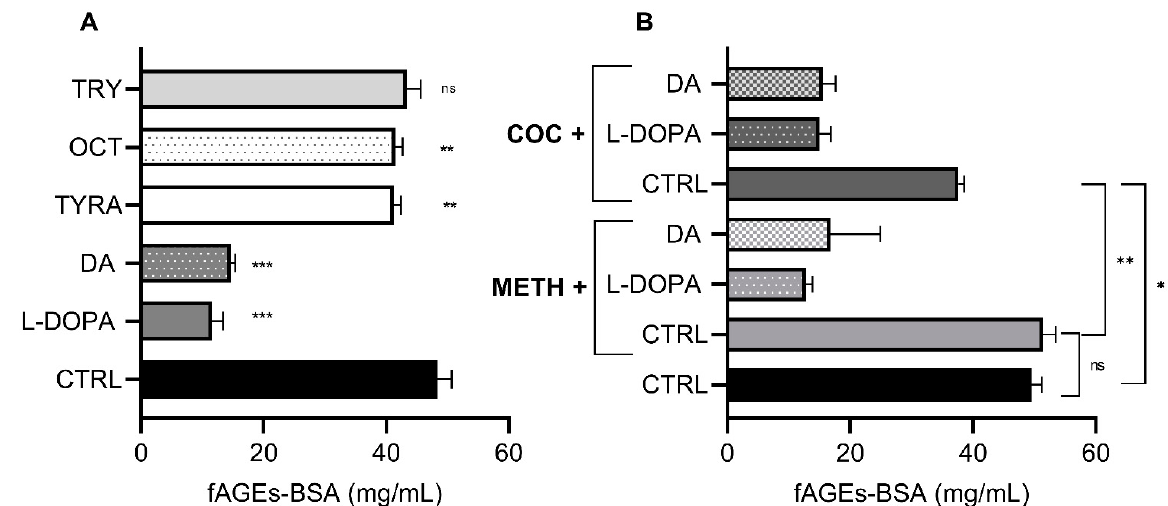
Figure 2. fAGEs-BSA formation is inhibited by 3,4-dihydroxy-L-phenylalanine (L-DOPA) and dopamine (DA) in vitro, regardless of the presence of cocaine (COC) or methamphetamine (METH). All samples were prepared in triplicates and all replicates were measured three times ( n = 9). Data are presented as mean ± SEM. ( A ) CTRL—concentration of fAGEs-BSA after hydrothermal synthesis with 50 mg/mL BSA, 0.5 M glucose and Na 2 HPO 4 buffer and with addition of: 10 mM of L-3,4-dihydroxyphenylalanine (L-DOPA), dopamine (DA), tyramine (TYRA), octopamine (OCT) or tryptophan (TRY). Significant values: **: p < 0.01, ***: p < 0.001 and non-significant (ns). ( B ) Concentration of fAGEs-BSA after hydrothermal synthesis with 50 mg/mL BSA, 0.5 M glucose and Na 2 HPO 4 buffer (CTRL) and in the presence of 10 mM methamphetamine (METH CTRL) and 10 mM cocaine (COC CTRL). Other samples in addition contained 10 mM of L-3,4-dihydroxyphenylalanine (L-DOPA) or dopamine (DA). Significant values: *: p < 0.05, **: p < 0.01 and non-significant (ns).